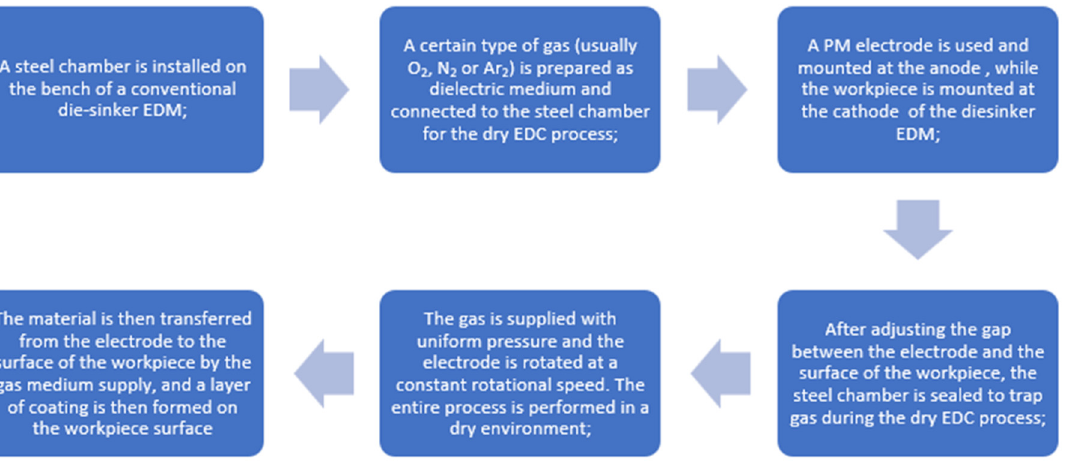
Figure 13. The working principles of dry EDC [271–273] .